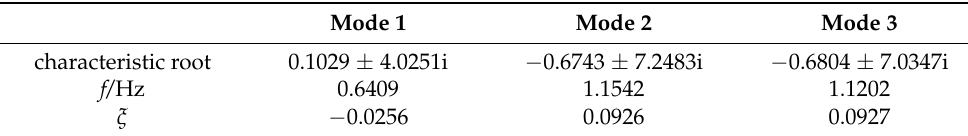
Table 3. Electromechanical modes without PSS.